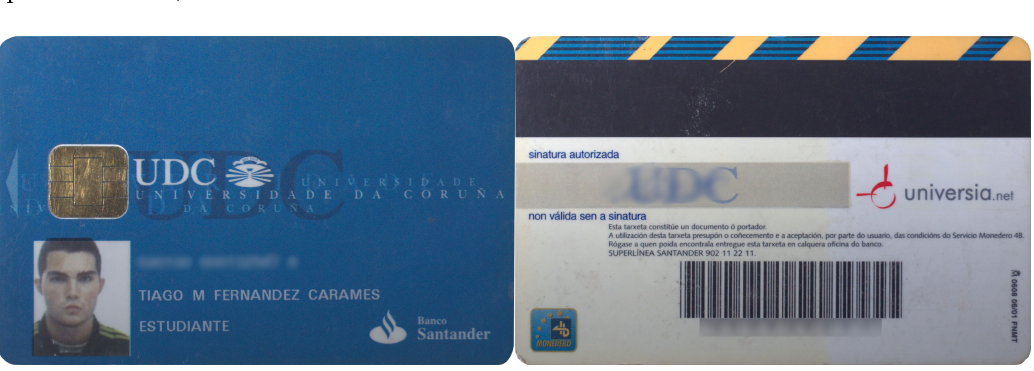
Figure 17. RFID card used in the University of A